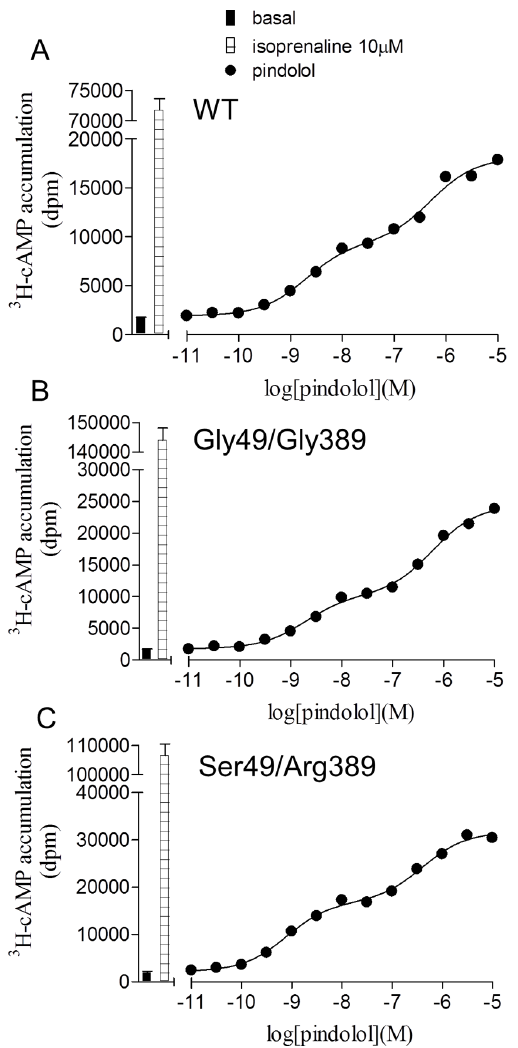
Figure 5. 3 H-cAMP accumulation in response to pindolol at the wildtype b 1-adrenoceptor and polymorphic variants. 3 H-cAMP accumulation in response to pindolol in A wildtype cells, B Gly49/ Gly389 cells and C Ser49/Arg389 cells. Bars represent basal 3 H-cAMP accumulation and that in response to 10 m M isoprenaline. Data points are mean 6 s.e.mean of triplicate determinations. These single experiments are representative of 5 separate experiments in each case and demonstrate agonist actions at both agonist conformations of the b 1-adrenoceptor in the wildtype and polymorphic variants.